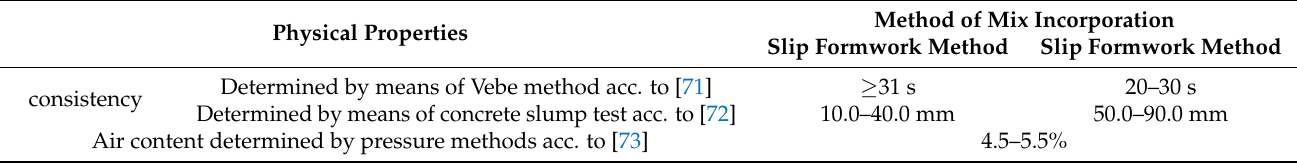
Table 3. Physical properties of